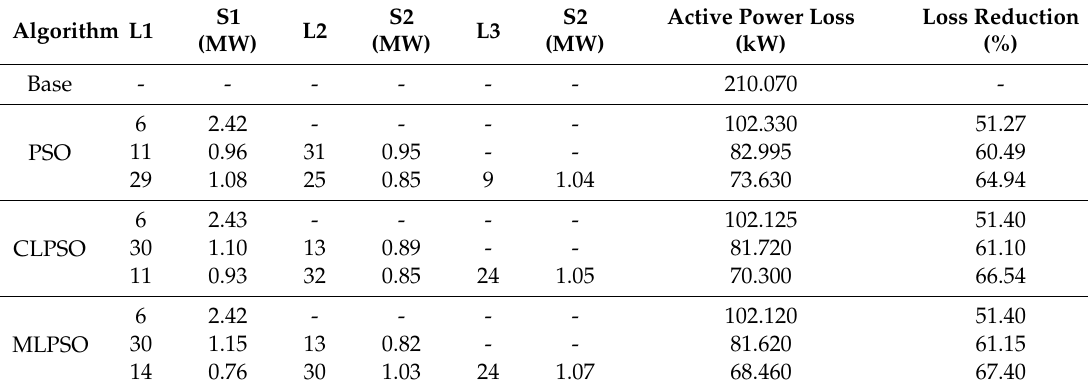
Table 3. Simulations results of optimal placement and sizing of DGs for PSO, CLPSO, and MLPSO algorithms—IEEE 33 bus system.